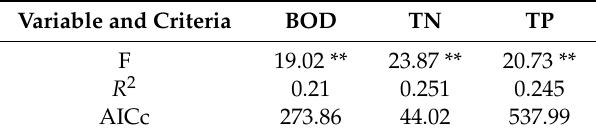
Table 5. The results of the generalized additive models (GAMs) for the relationships between the proportion of urban land use and water quality indicators. The non-linear model for TN had the highest R 2